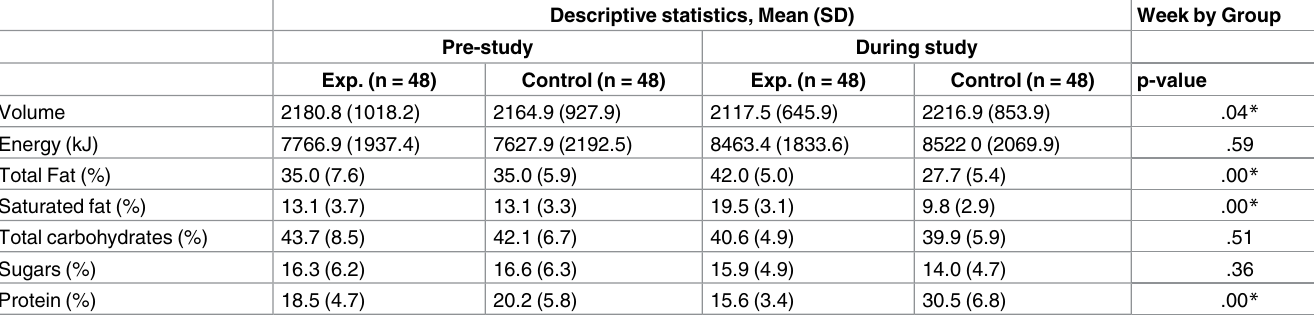
Table 4. Nutritional breakdown of self-report food diaries prior to and during the study.